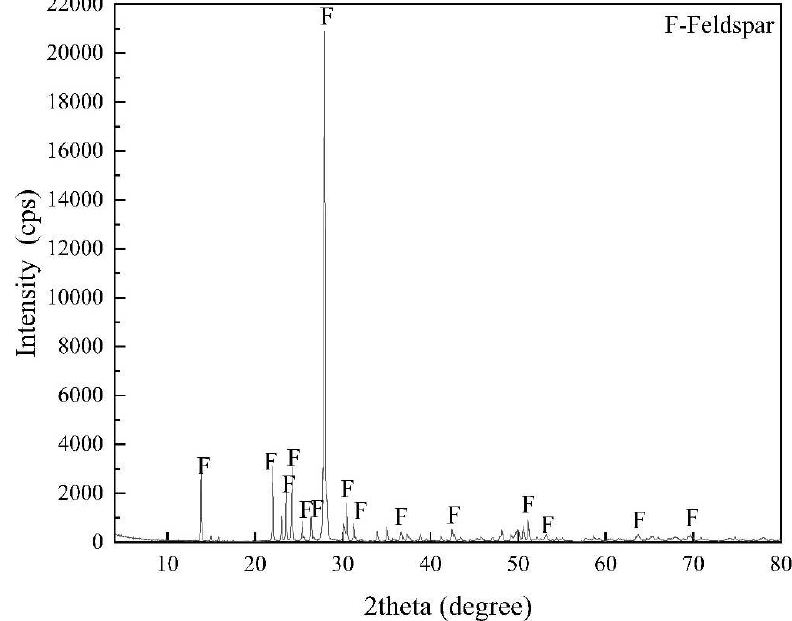
Figure 1. X-ray diffraction (XRD) spectra of feldspar.